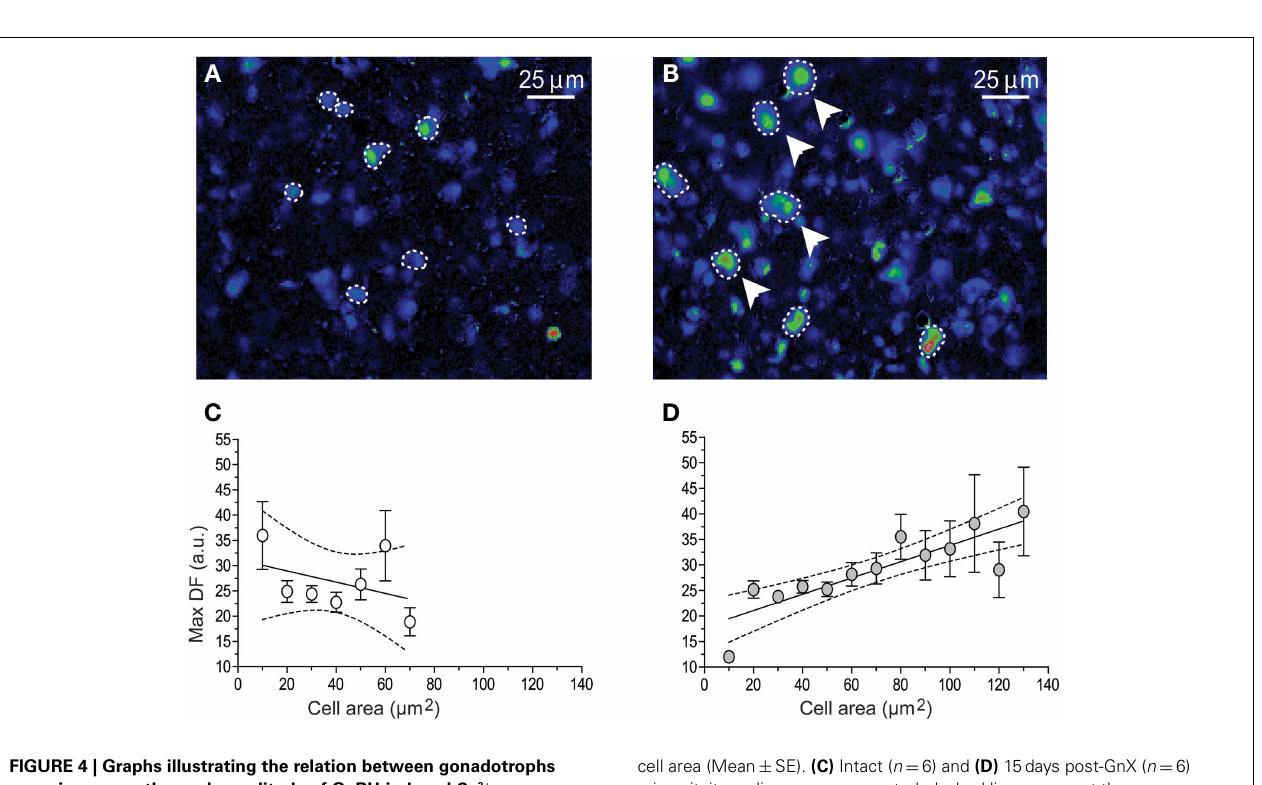
FIGURE 4 | Graphs illustrating the relation between gonadotrophs area size versus the peak amplitude of GnRH-induced Ca 2 + transients . Fluo-4 fluorescence images of 100nM GnRH responding gonadotrophs (dashed lines) in intact (A) and 15days post-GnX (B) mice pituitary slice, arrows pointed bigger gonadotrophs. (C,D) shows the relationship between [Ca 2 + ] i transients peak amplitude (Max DF) and